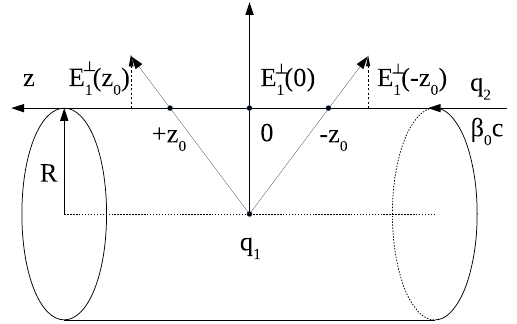
Fig. 2 The electrical field from the charge q 1 at rest acting on the charge q 2 from another